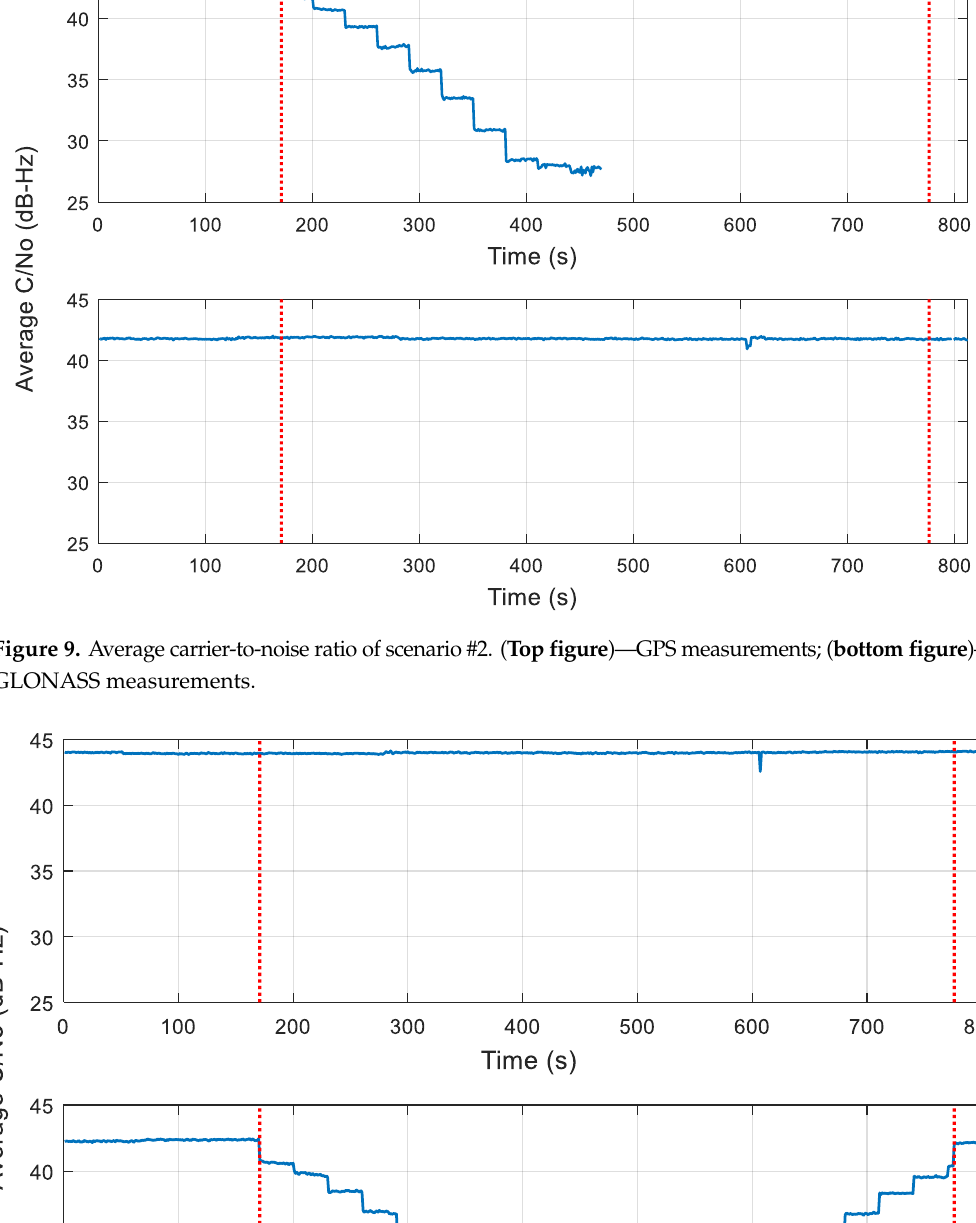
7 Table 6. Minimum number of available satellites for scenario #3. Jamming Power (dBm)